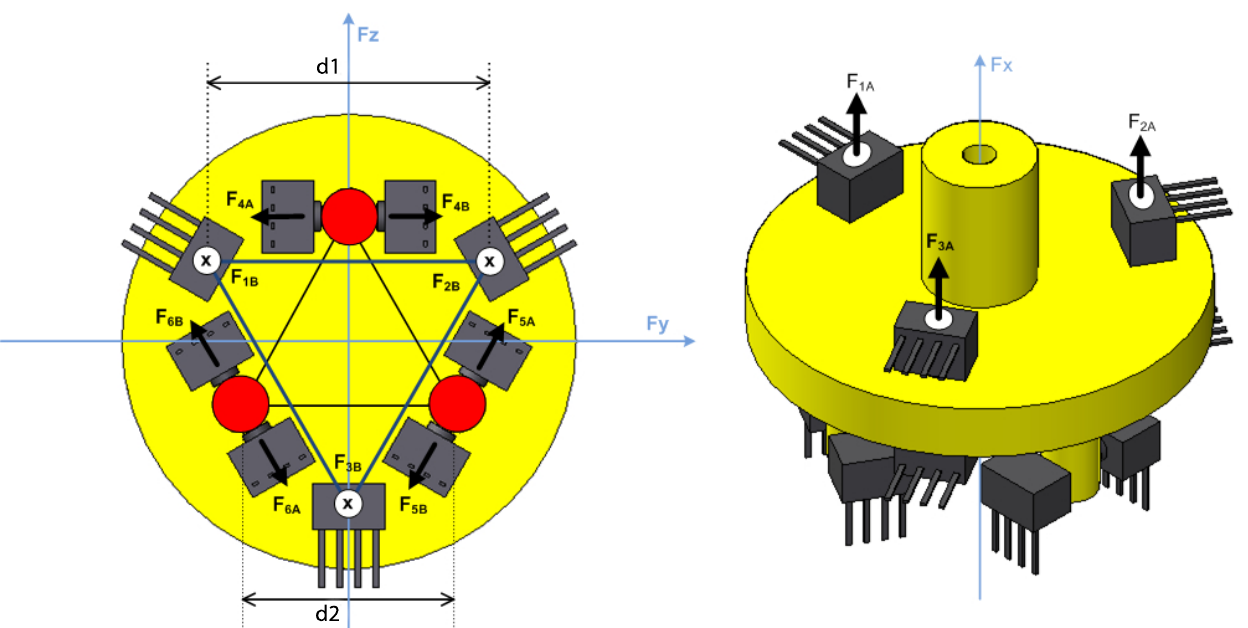
Figure 5. Schematic of sensor